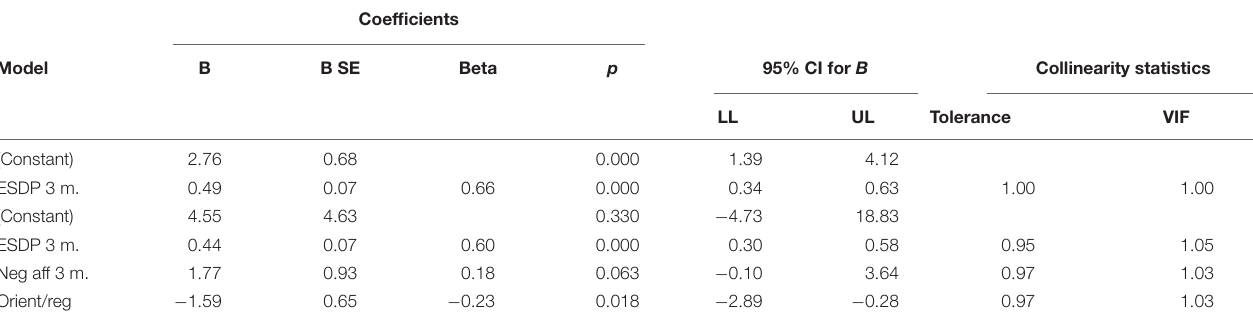
TABLE 4 | Regression: maternal EPDS scores, infant negative affectivity, and infant Orienting/regulation at 3 months as predictors of EPDS scores at 6